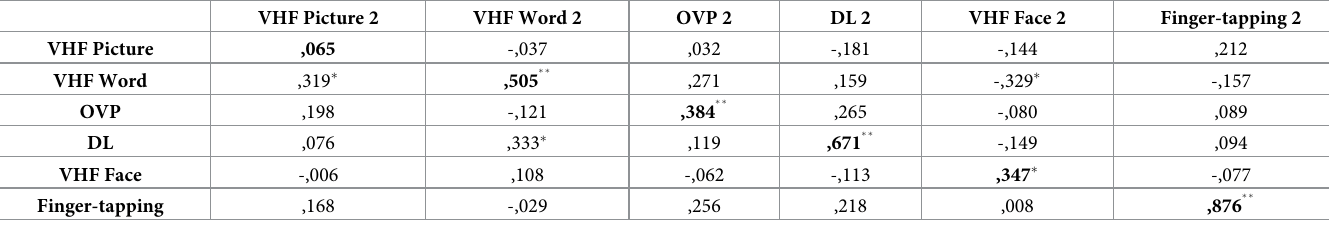
Table 6. Pearson correlations between the lateralization indices based on error rates for session 1 (variables in rows) and session 2 (variables in columns, indicated by task name 2). The test-retest correlations per task are highlighted in bold. Note that correlations with fingertapping lateralization indices are only included in this table, not in Table 5.